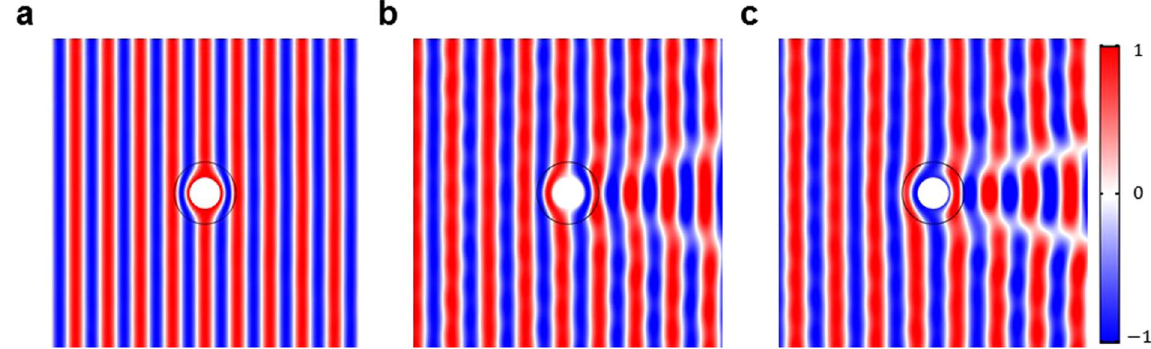
Figure 2. Total acoustic pressure around acoustic cloak. ( a ) The acoustic pressure around an existing cloak 1 in stationary medium. ( b ) and ( c ) The acoustic pressure around convective cloaks 7 in moving media with M = 0.1 and M = 0.2, respectively. For all figures, the total acoustic pressure is normalized by incident wave, i.e ., ′ ′ p p / and the incident angles and the Helmholtz numbers are set as α = 0 and kR 1 = 3. As shown in ( a ), the acoustic cloak hides an object in the absence of flow and our numerical simulation shows good accuracy. On the other hand, as shown in ( b ) and ( c ), acoustic cloaks in moving media lose their hiding function as the Mach number increases, especially in forward scattering regions.